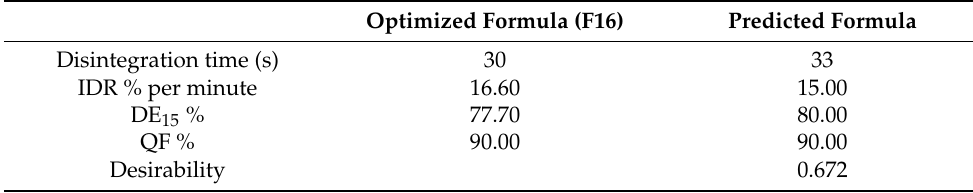
Table 5. Results of the optimized versus the predicted